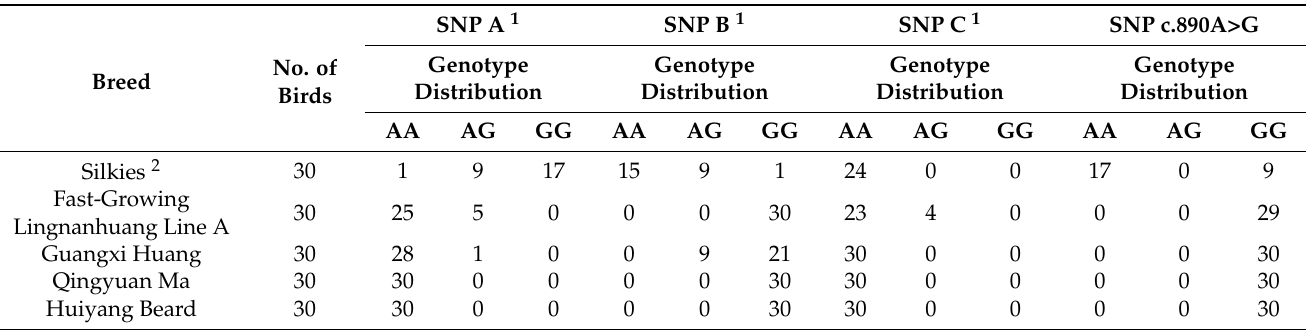
(Table 3). The allelic frequencies of the SNP c.890A>G in white-skin and yellow-skin chicken breeds were notably different. As shown in Table 3, allele A was predominant in those breeds with a white skin, such as Qingjiao Ma, Youxi Ma, and Mahuang with black shank. Allele G was predominant in yellow skin breeds, including Huiyang Beard, Fast-Growing Lingnanhuang Line A, Mahuang with navy shank, and Guangxi Huang Chicken. Table 2. Genotype distribution for the SNP A, SNP B, SNP C, and SNP c.890A>G in the BCO2 gene in 5 chicken breeds.